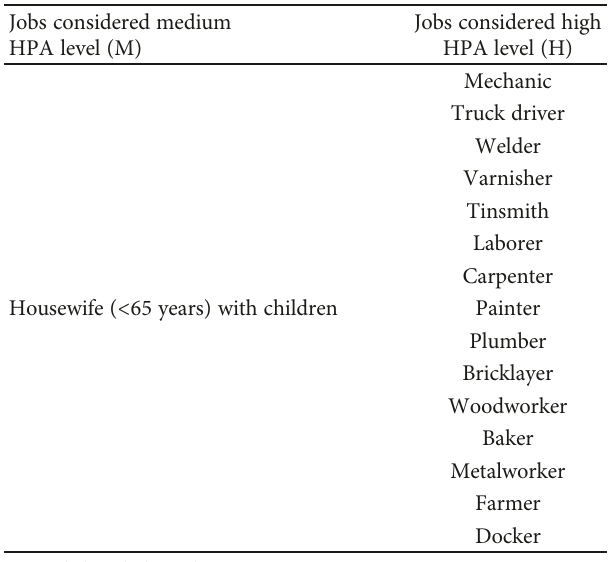
Table 2: List of physically demanding